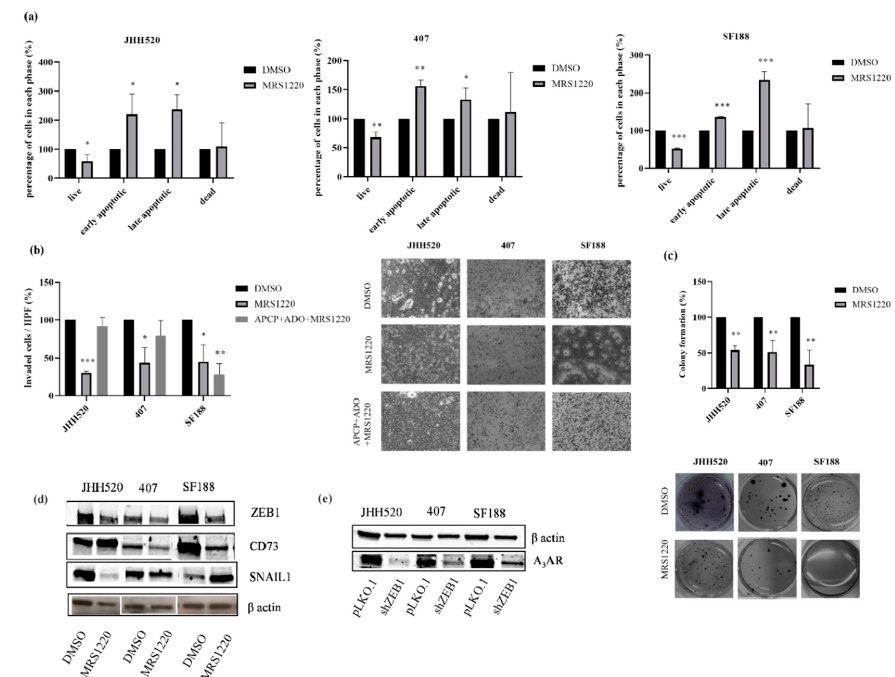
Figure 6. Pharmacological inhibition of the A 3 A receptor reduces stemness and mesenchymal characteristics in GSCs. ( a ) Pharmacological inhibition of A 3 AR with 10 µ M MRS1220 for 24 h induced apoptosis as assessed with the Muse ® Annexin V and Dead Cell Kit. Data normalised over the DMSO controls. ( b , c ) MRS1220 (10 µ M) reduced the invasive and clonogenic capacities of GSCs. ( d ) ZEB1 protein expression levels were decreased in MRS1220 (10 µ M)-treated cells comparing to the control (DMSO) whereas CD73 and SNAIL1 protein expression levels showed no common